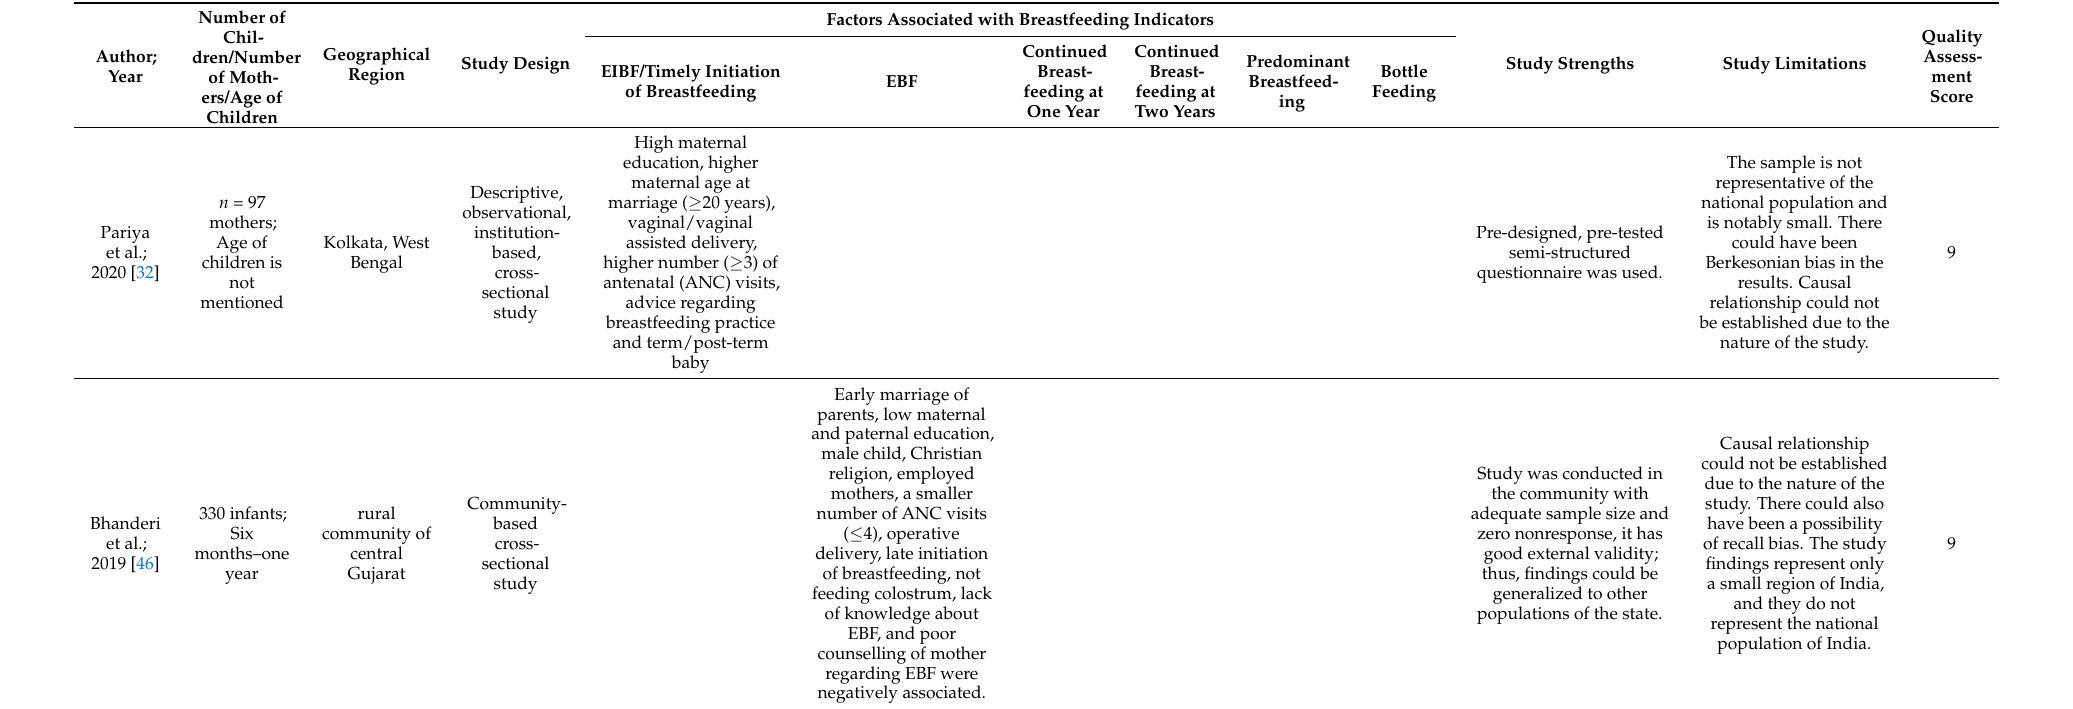
Table A1. Summary of selected studies: Breastfeeding